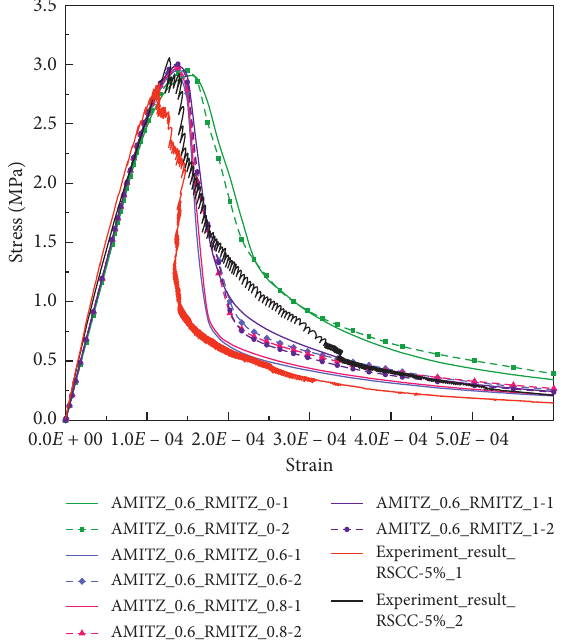
Figure 12: Stress-strain curves of varying thickness R-M ITZs